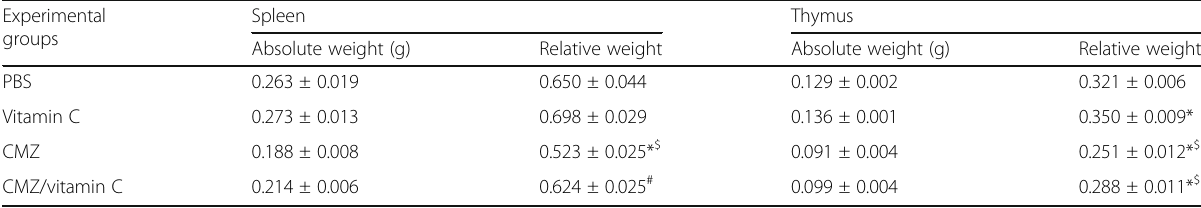
Table 2 Changes in the weights (absolute and relative) of immune-related organs (spleen and thymus) of male Swiss albino mice treated with PBS, vitamin C (1136 μ M/kg), CMZ (46 μ M/kg), or a combination of CMZ and vitamin C with the same dose of each intraperitoneally (i.p.) daily over 4 weeks